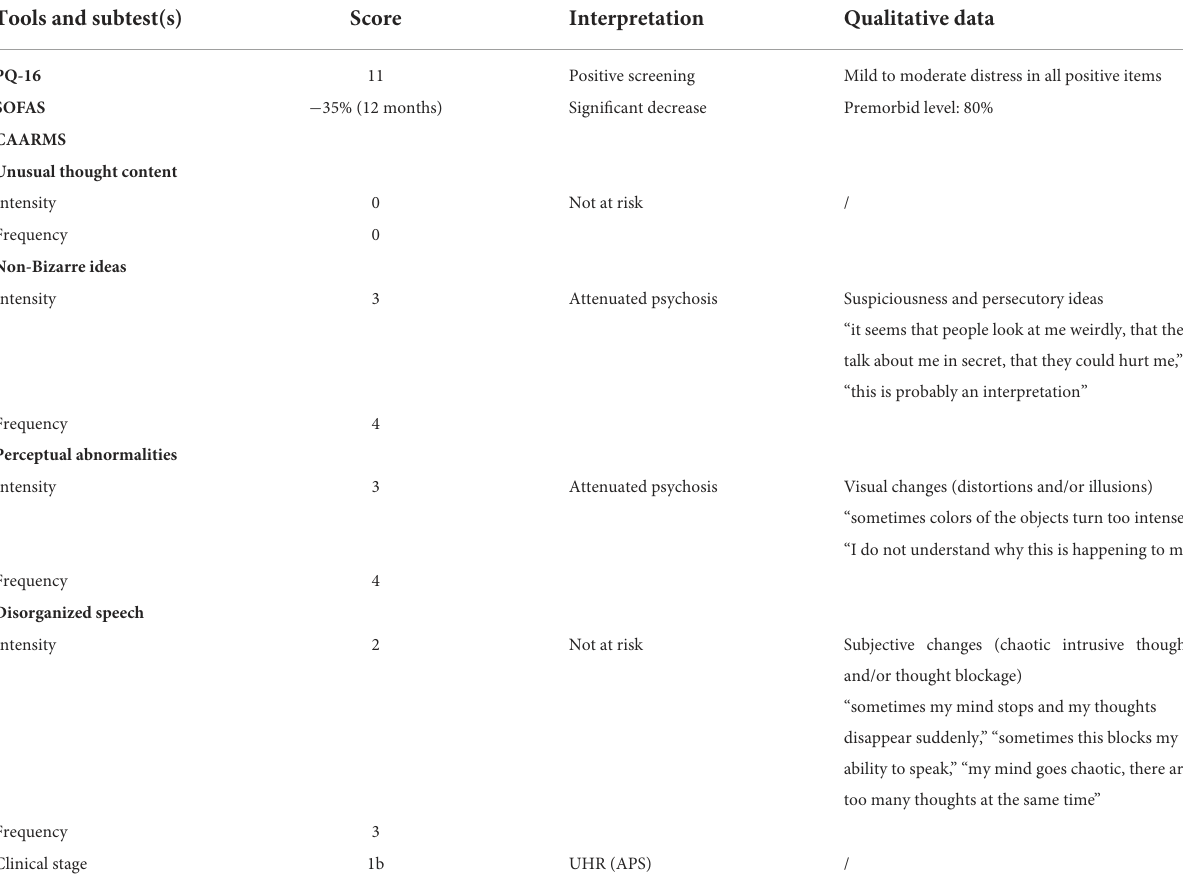
TABLE 2 UHR for psychosis assessment